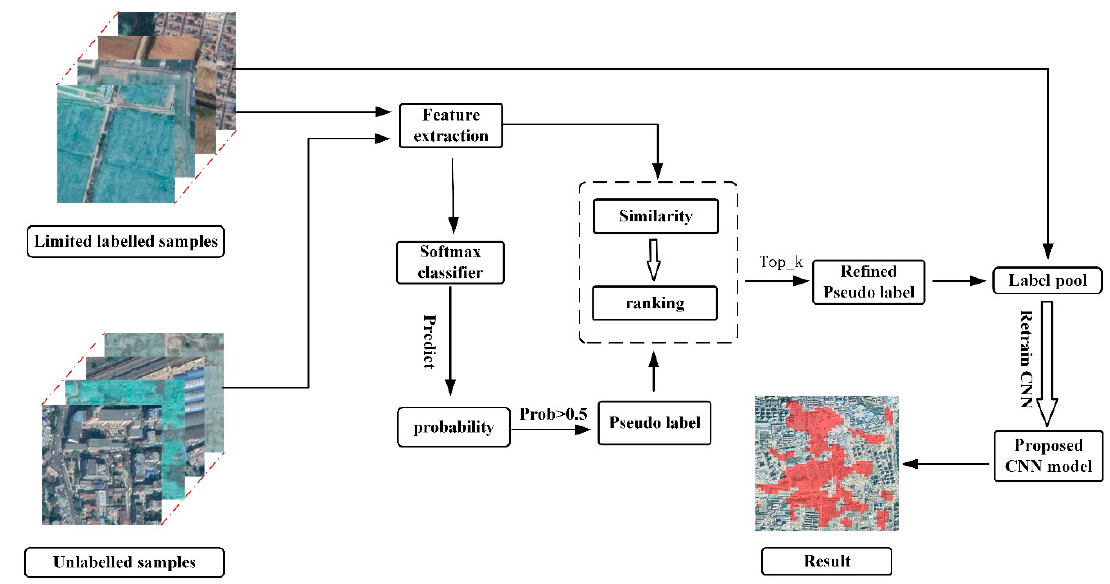
Figure 5. Overview of the proposed method for green plastic cover mapping.